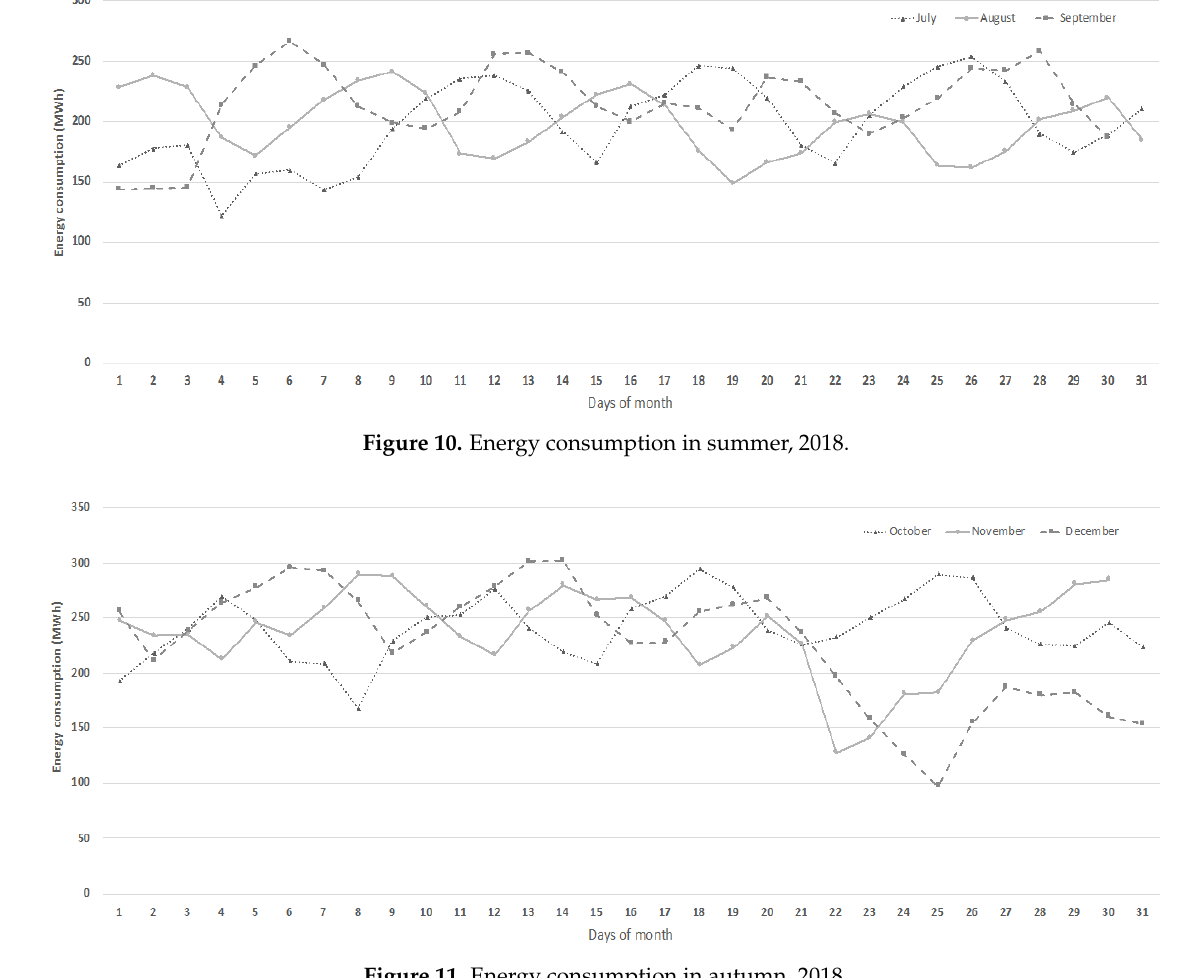
Figure 11. Energy consumption in autumn, 2018.